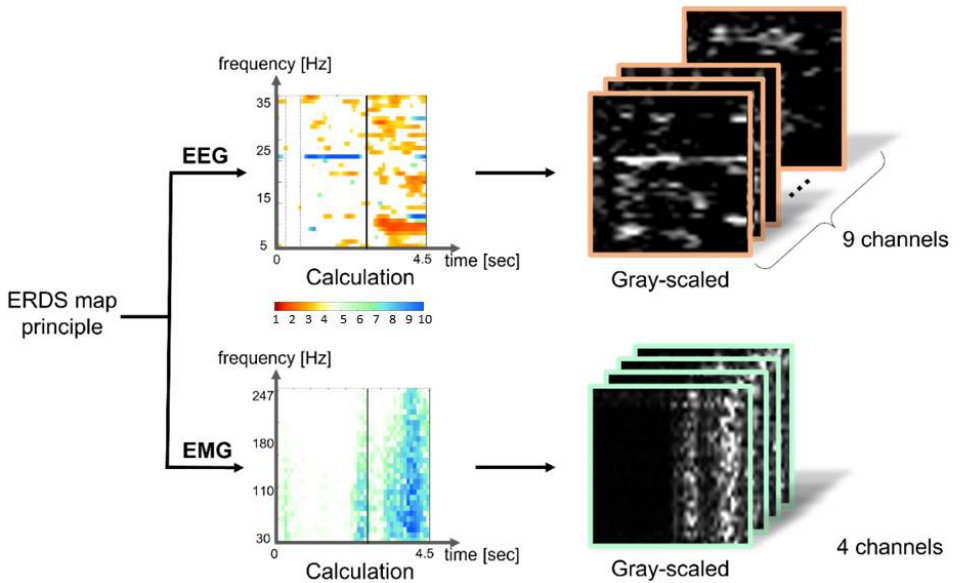
Figure 4. Two-dimensional (2D) image of EMG signal generated using an ERDS principle, a feature extraction technique for EEG signals in frequency domain. The signals were provided as inputs to the training model.